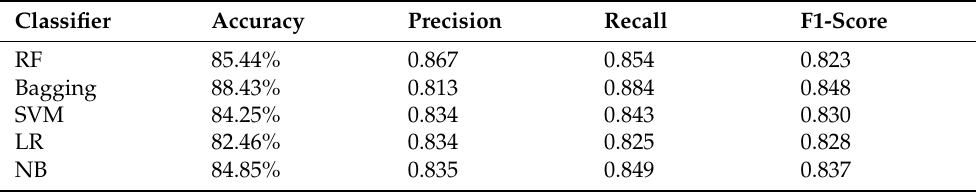
Table 25. Experiments with ML models and BoW and all lexicons on Arab TextBlob